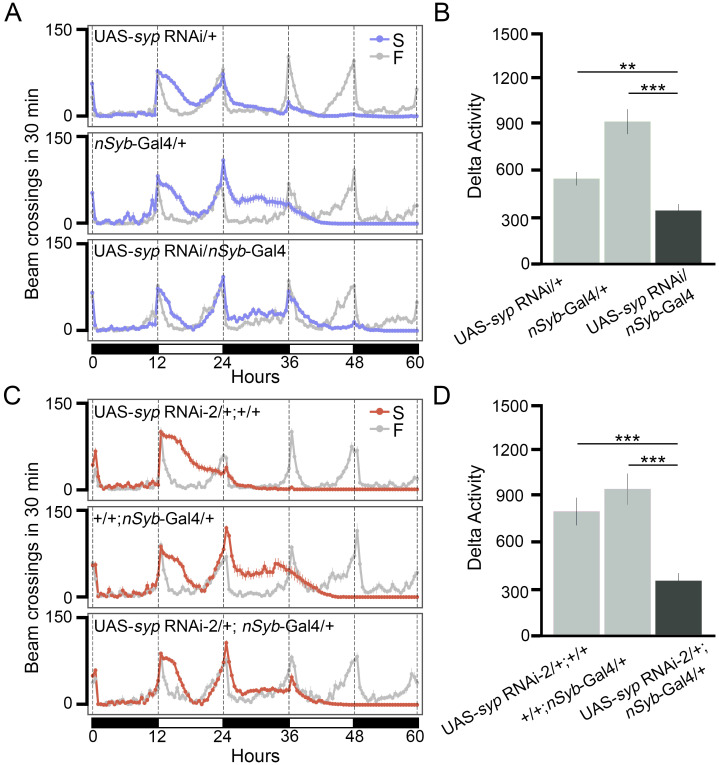
Knocking down of syp in neurons reduces SIH.(A) Locomotor activity responses to starvation from neuron-specific syp knockdown flies (genotype: UAS-syp RNAi/nSyb-Gal4) and two parental control lines (genotypes: UAS-syp RNAi/+ and nSyb-Gal4/+, respectively). Gray lines represent activities under the food condition (F) and purple lines represent activities under the starvation condition (S). Black and white bars at the bottom of the panel represent night and day cycles, respectively. n = 16-20 per genotype per condition. (B) Summary plot of SIH in panel A. (C) Locomotor activity responses to starvation from neuron-specific syp knockdown flies generated from a second RNAi line (genotype: UAS-syp RNAi-2/+; nSyb-Gal4/+) and two parental control lines (genotypes: UAS-syp RNAi-2/+; +/+ and +/+; nSyb-Gal4/+, respectively). n = 20-24 per genotype per condition. (D) Summary plot of SIH in panel C. ** P < 0.01, *** P < 0.001, unpaired t-test with Bonferroni Correction. Error bars represent SEM.